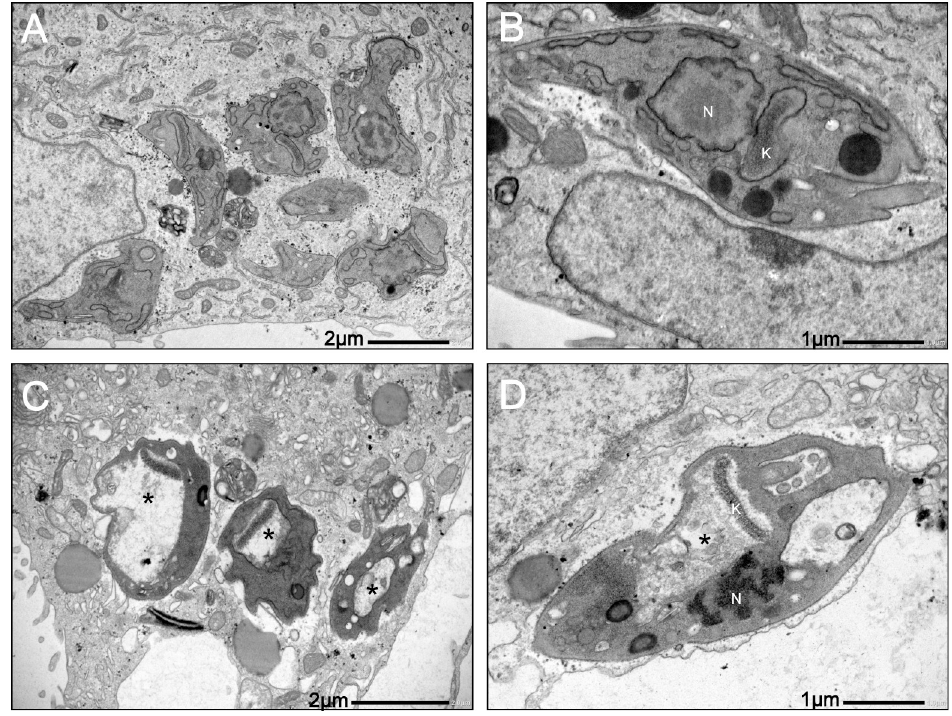
Fig 3. Transmission electron micrographs showing the ultrastructure of intracellular amastigotes. Nucleus (N); kinetoplast (K); � Swollen mitochondria. A-B: Control untreated; C-D: Parasites treated 4 hours with IC 50 of isoobtusilactone